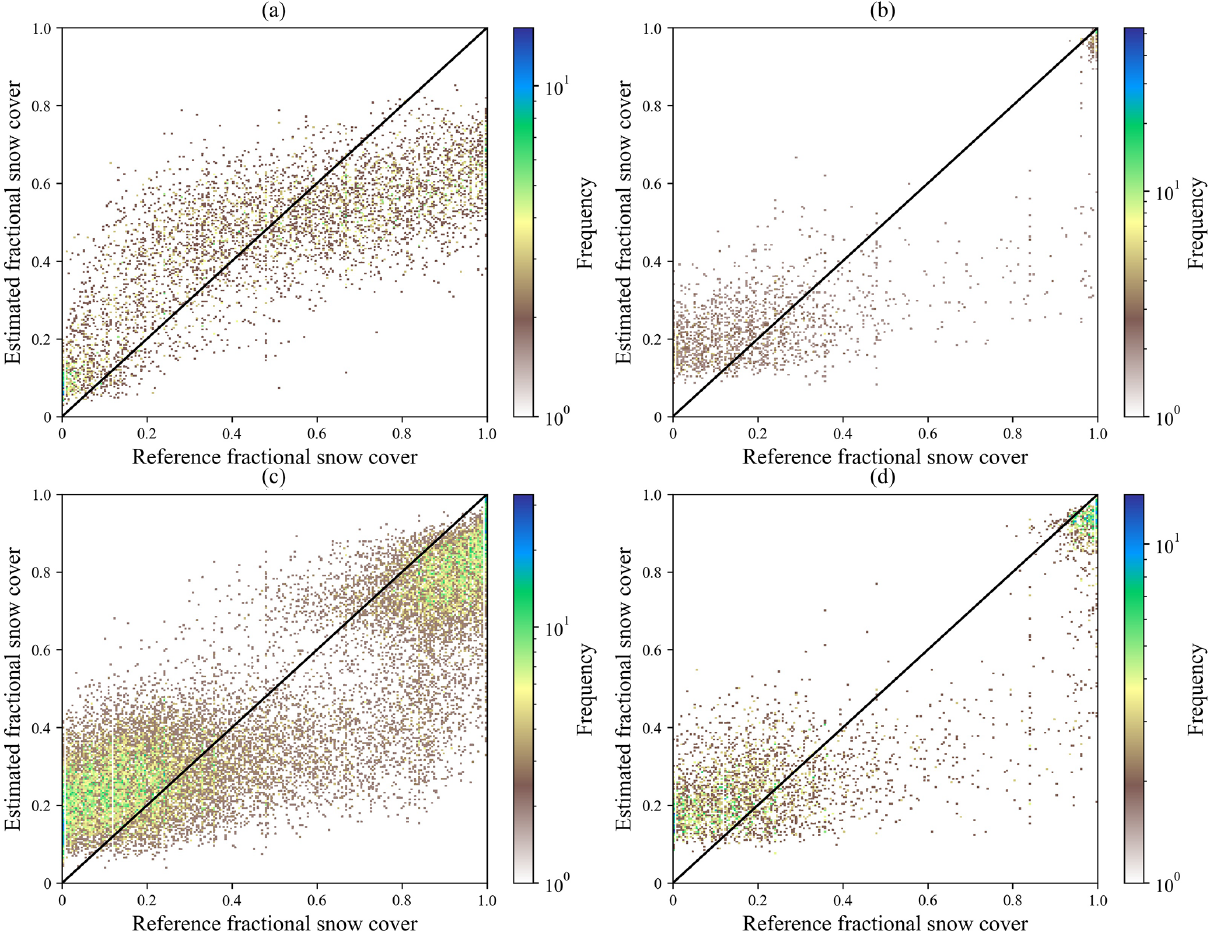
Figure 8. The color density scatter plots between the estimated fractional snow cover and MODIS-derived fractional snow cover in December for four land cover types: forest (a) , shrub (b) , prairie (c) , and bare land (d) . Statistics metrics refer to Table 6: Evaluation 2. Note that 0.3% of the independent evaluation dataset in December of 2007, 2008, and 2016 was randomly selected as the evaluation sample with stratified random